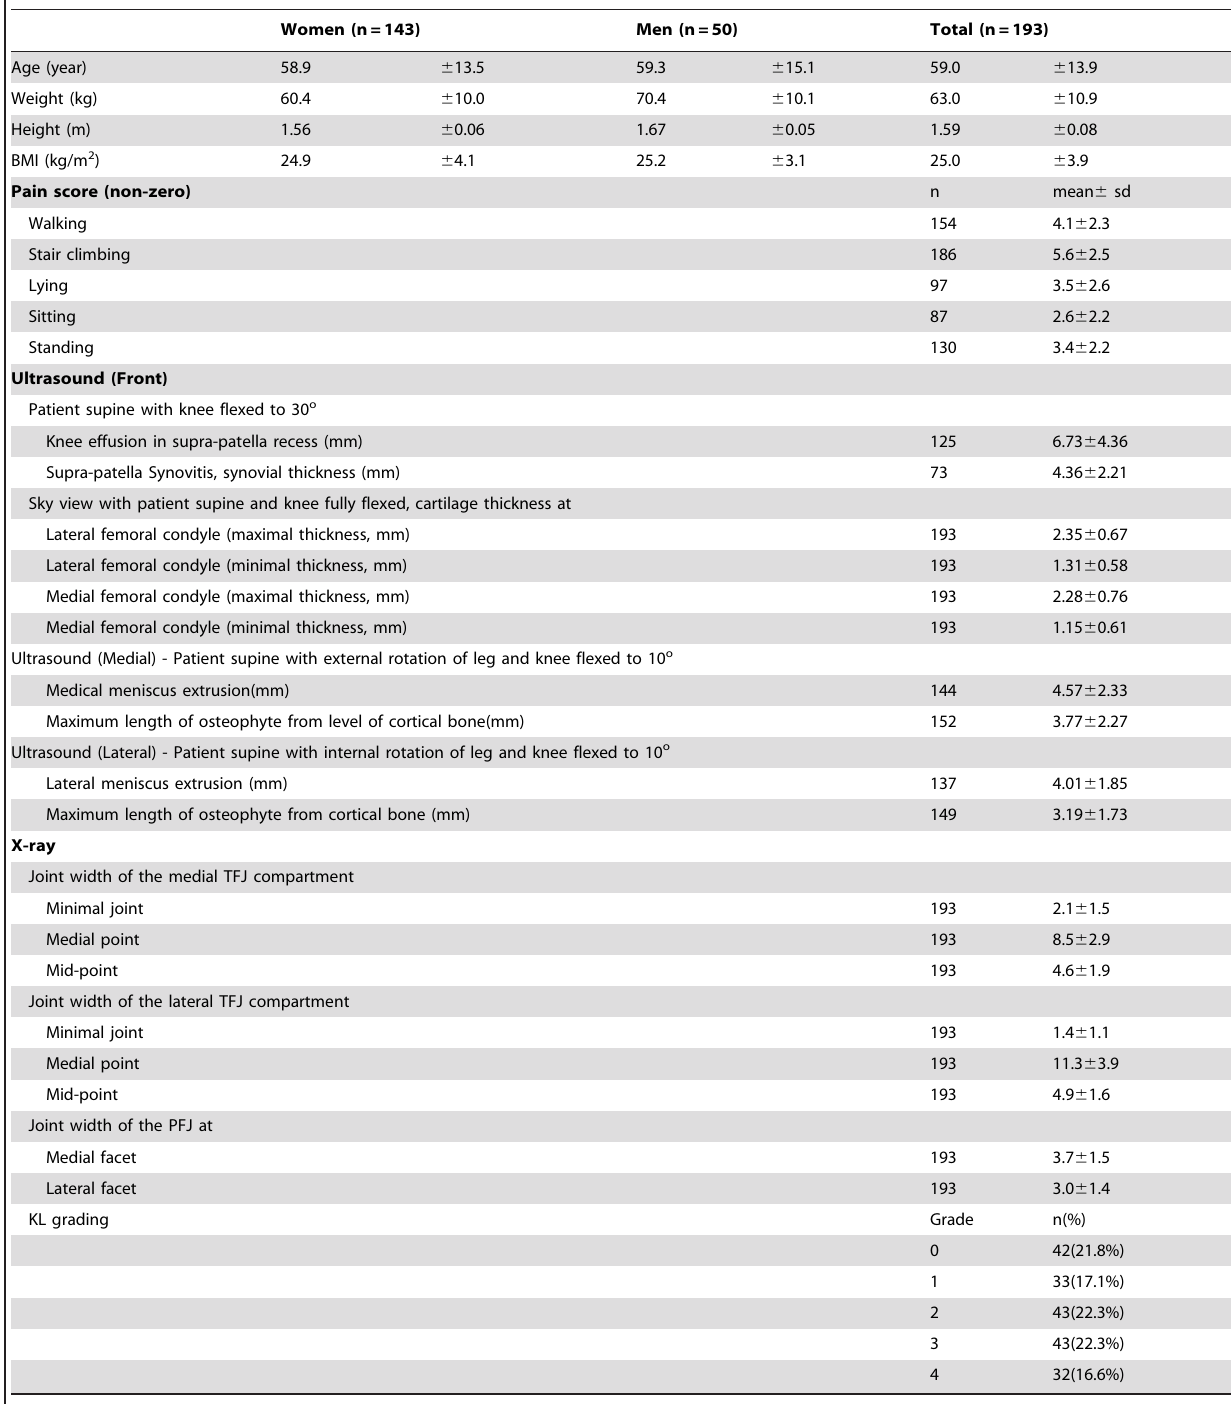
Table 1. Characteristics of the study subjects (N=